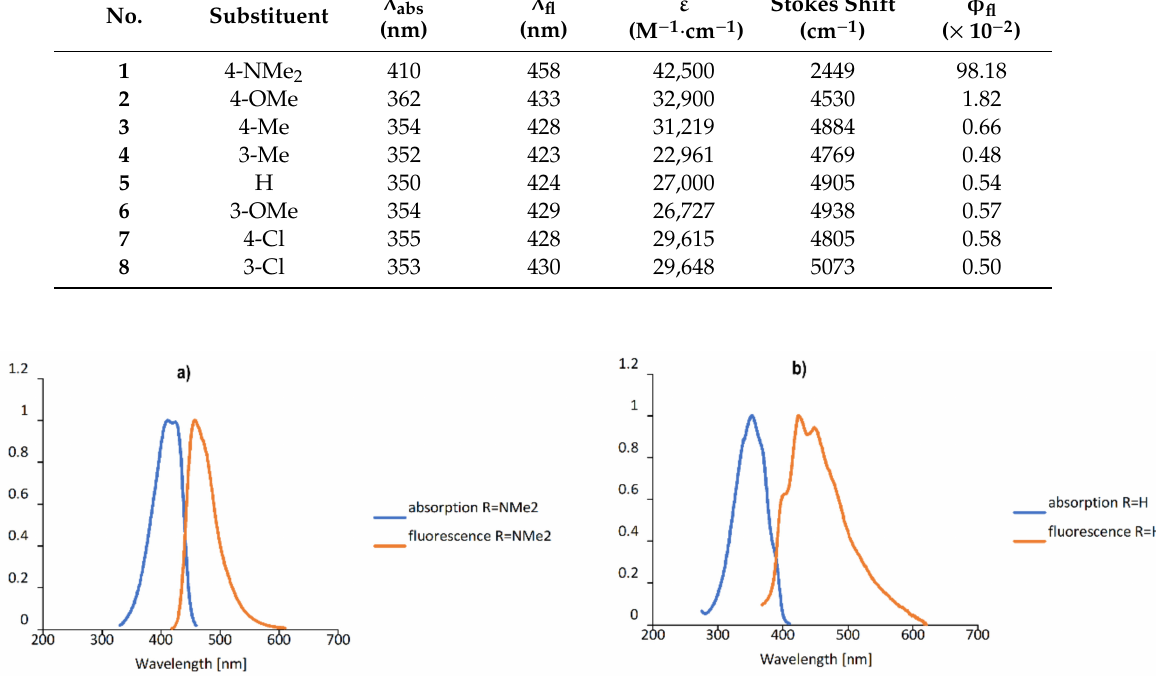
Figure 3. The normalized UV-Vis absorption ( a ) fluorescence and ( b ) spectra of 1 and 5 in CHCl 3